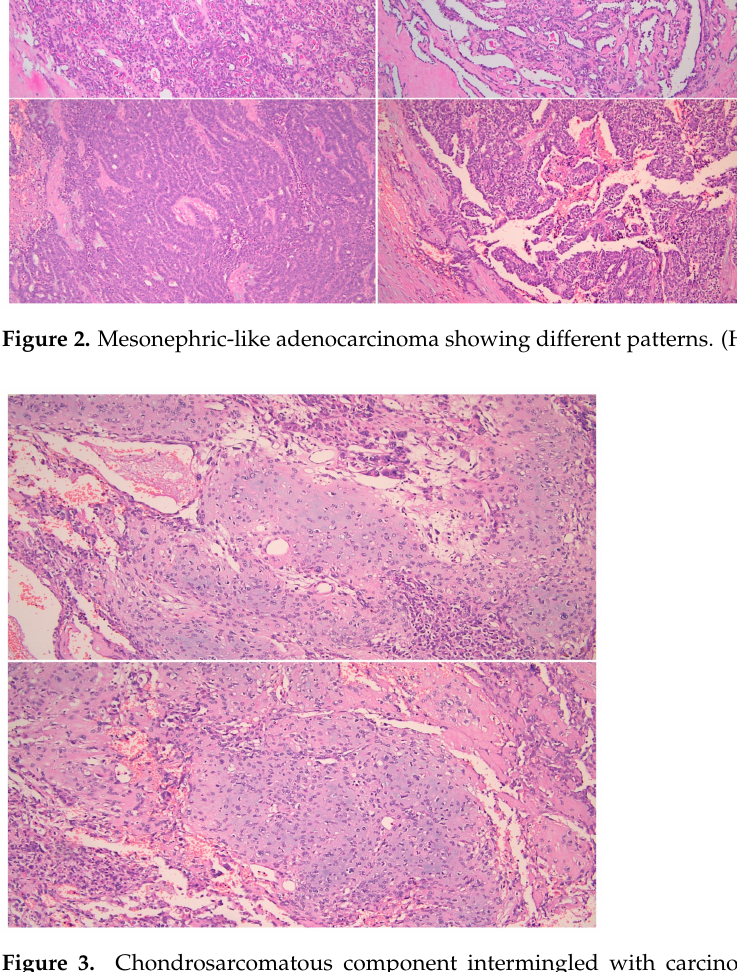
Figure 3. Chondrosarcomatous component intermingled with carcinomatous neoplastic cells. (HE, 200 ×